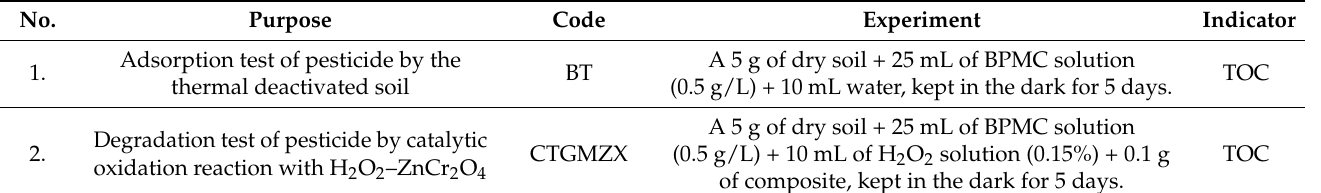
Table 1. Procedure of ZnCr 2 O 4 /CNS application in dark degradation of pesticide.